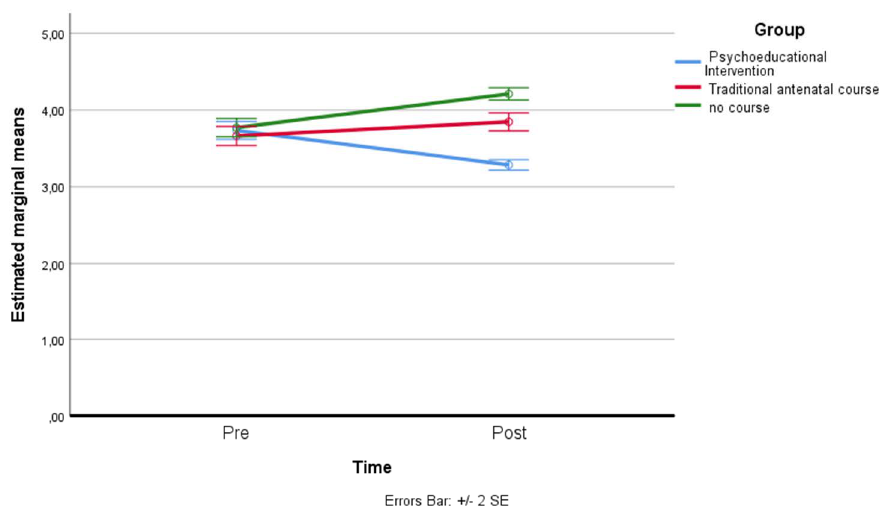
Figure 2. Estimated marginal means of state anxiety.